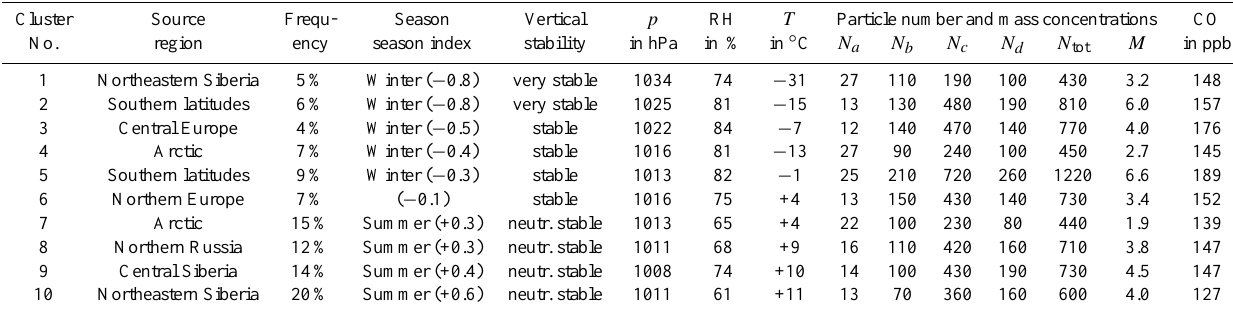
Table 2. Summary of the ten trajectory clusters including climatological frequency, characteristic season, mean meteorological parameters (air pressure, relative humidity, and temperature), mean particle concentrations at the 300m level for several diameter intervals, and mean CO mixing ratios. The meteorological parameters are averages of the 19:00LT observations at the Russian meteorological service station at Vorogovo, 30km north of ZOTTO.